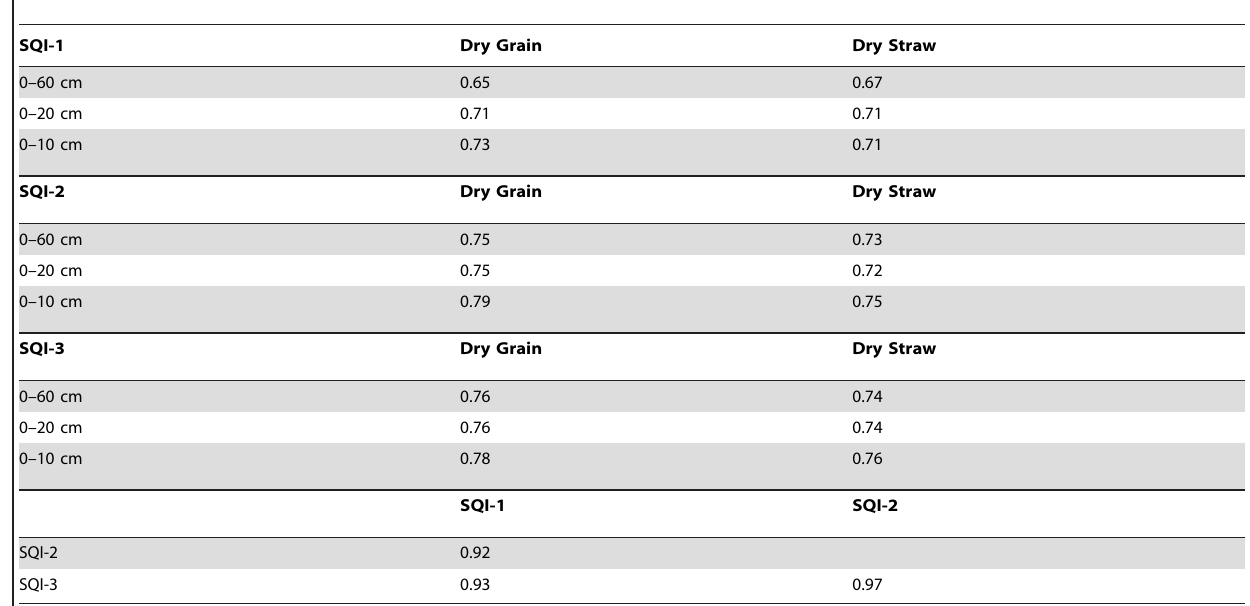
Table 7. Pearson correlation coefficients (r) of soil quality index (SQI) versus crop yield and correlations between different SQI values which were averaged up to a certain depth; all numbers are significant at p , 0.05